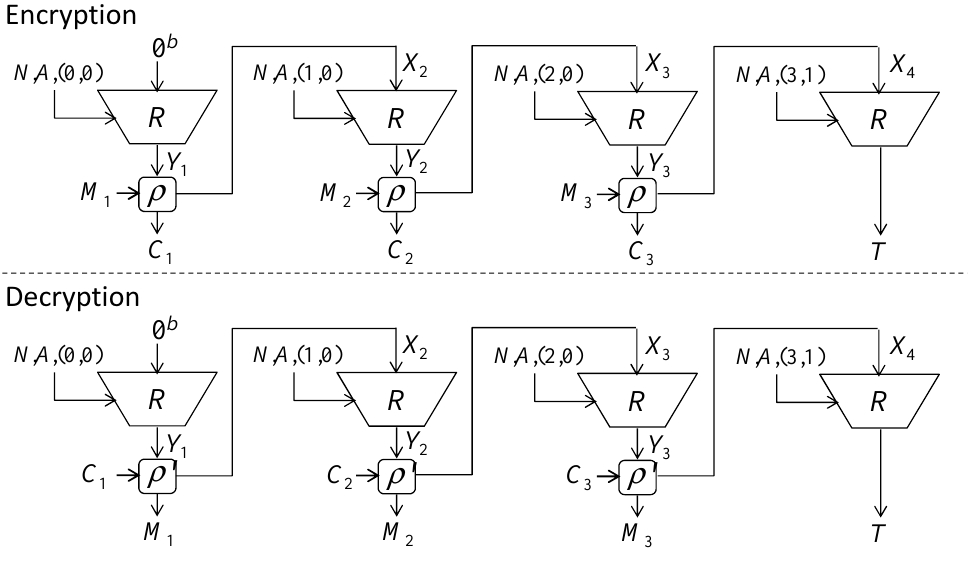
Figure 1: iCOFB . M 1 , M 2 , M 3 are b -bit plaintext blocks, C 1 , C 2 , C 3 are b -bit ciphertext blocks, and T is a b -bit